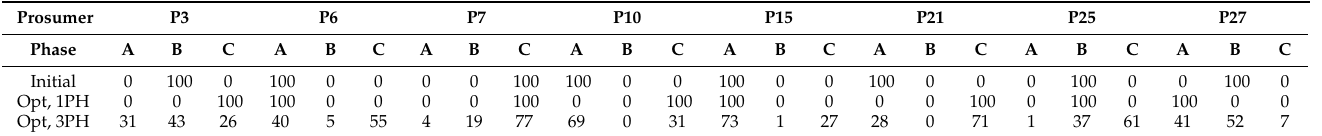
Table 3. Surplus redistribution solutions for network R28, in percent.